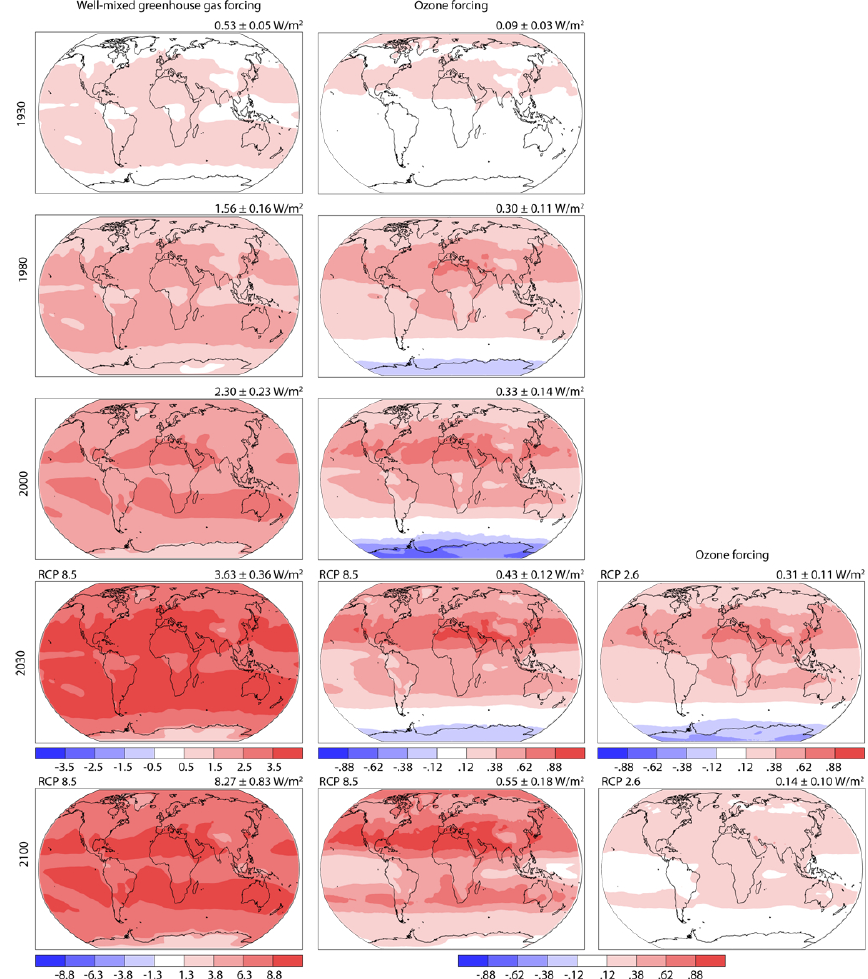
Fig. 20. Maps of WMGHG and ozone RF (Wm − 2 ) for various historical and future times/scenarios. Note change in scale for WMGHGs in